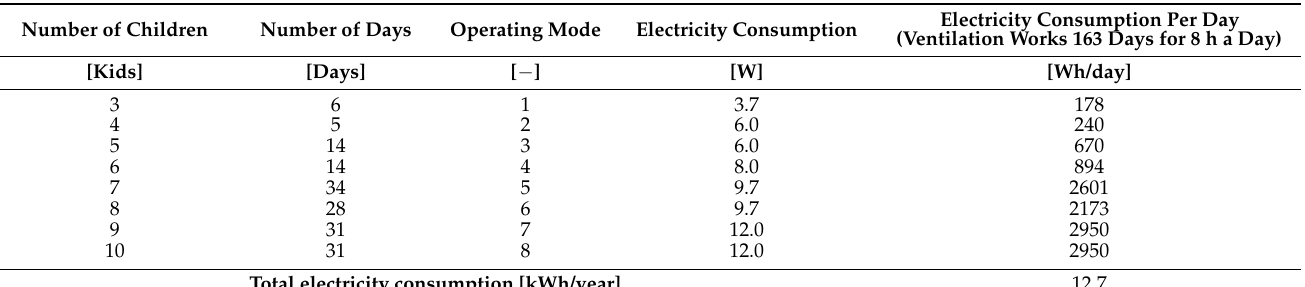
Table 7. Annual consumption of final energy for purpose of mechanical